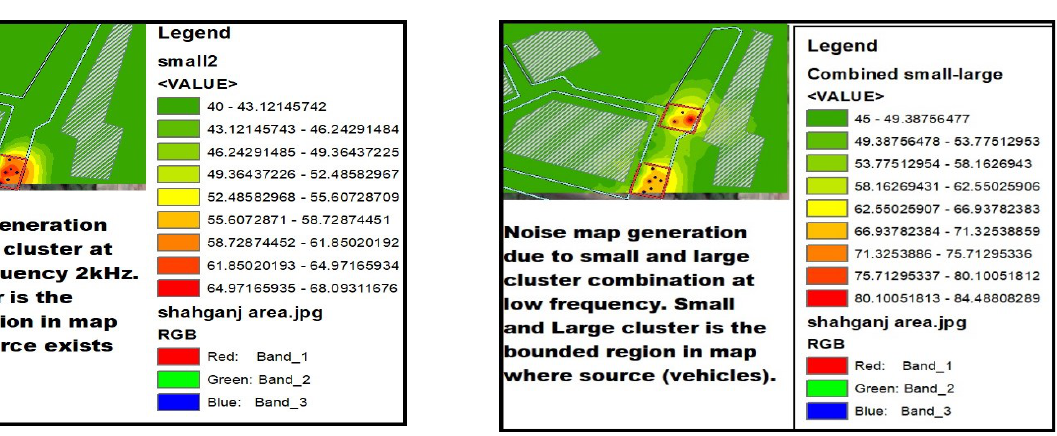
Figure 11. Noise map for the small cluster at medium freq. 2kHz.